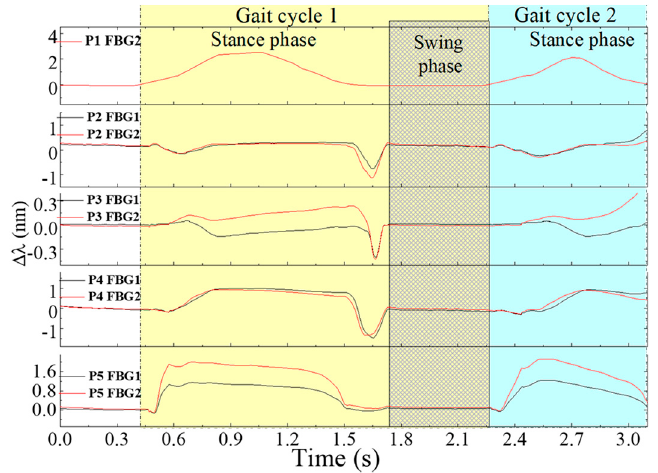
Figure 10. Bragg wavelength shifts in time, registered for each FBG in the 5 points of analysis.